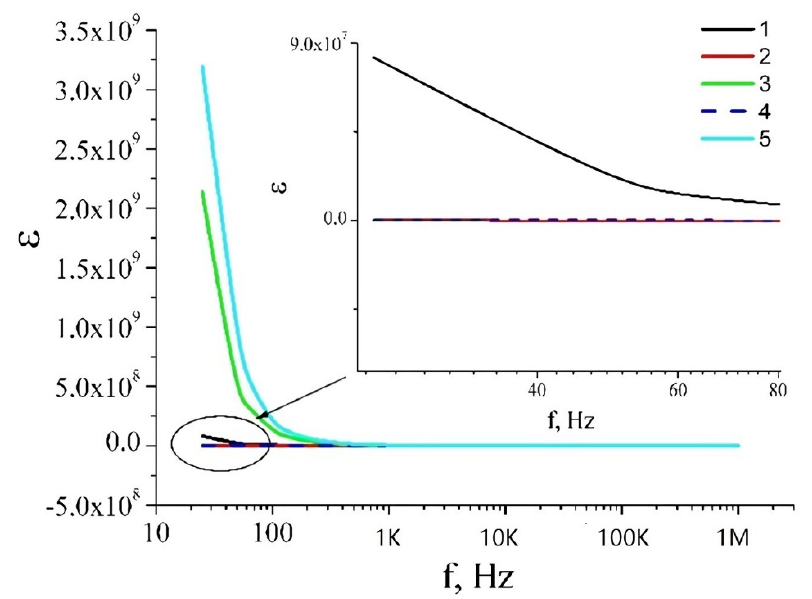
Figure 10. Dependences of dielectric permittivity of films: ( 1 ) TiO 2 layer; ( 2 ) two layers: TiO 2 /Ag_NW; ( 3 ) two layers: TiO 2 /Ag_NW_MW; ( 4 ) three layers: TiO 2 /Ag_NW/TiO 2 ; ( 5 ) three layers: TiO 2 /Ag_NW_MW/TiO 2 .